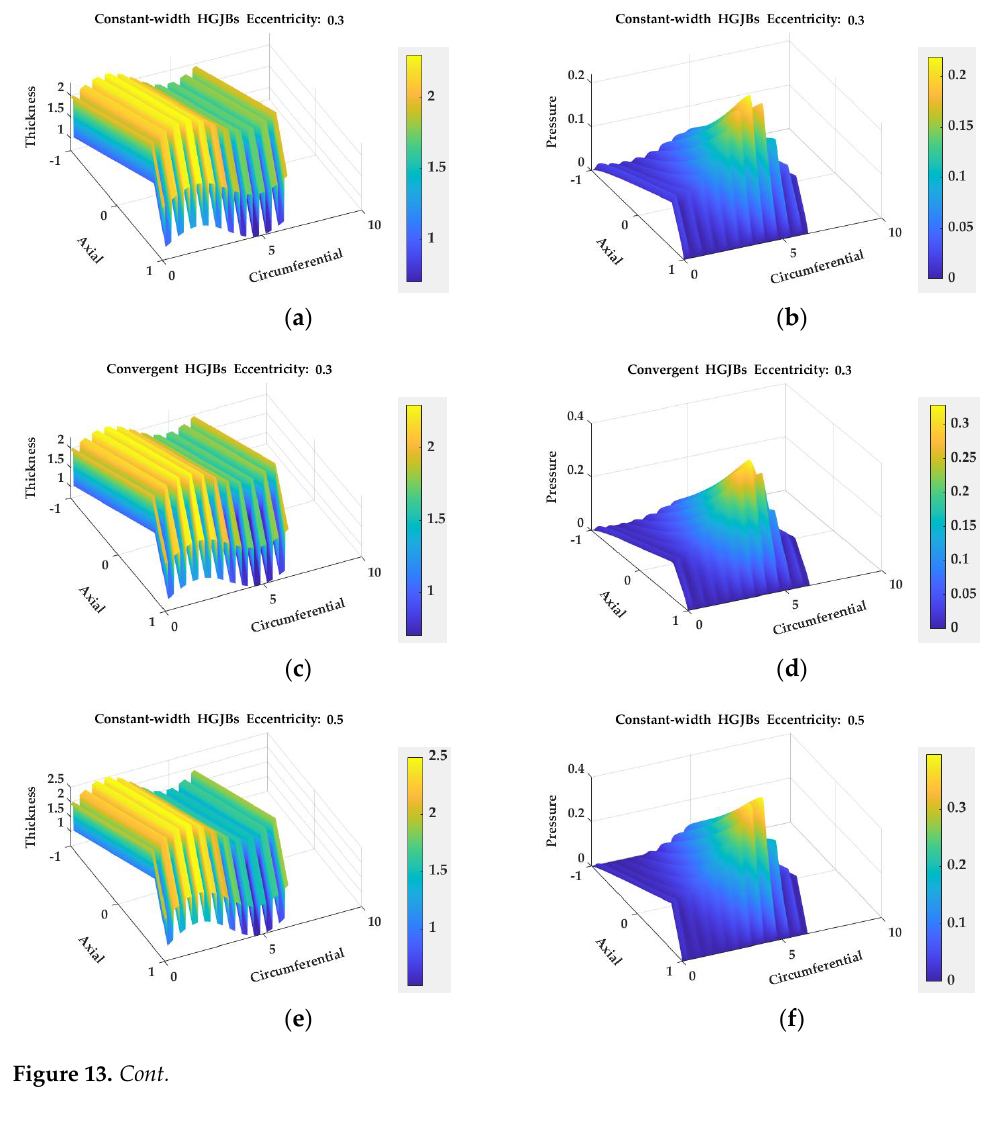
( h ) Figure 13. Comparison of two bearing oil film thickness and pressure: ( a , b , e , f ) are the calculation results of the constant—width HGJBs; ( c , d , g , h ) are the calculation results of the convergent HGJBs. Figure 13 shows that due to the presence of herringbone grooves, the oil film of HGJBs is distributed in steps, which can be divided into groove areas and ridge areas along the circumferential direction. Assuming that the herringbone groove is set on the shaft and the corresponding bearing bush is smooth, the shaft rotates at a certain speed and pumps the liquid on one side of the bearing. This phenomenon is called the pumping effect. Therefore, the pressure distribution diagram shows that the pressure of the HGJBs is distributed in a zigzag shape in the circumferential direction, and each groove will have